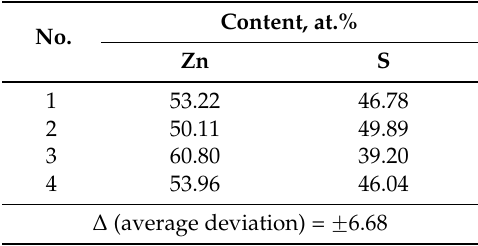
Table 2. Chemical composition (at.%) of zinc sulfide films electrodeposited at 30 ° C. Components Content,